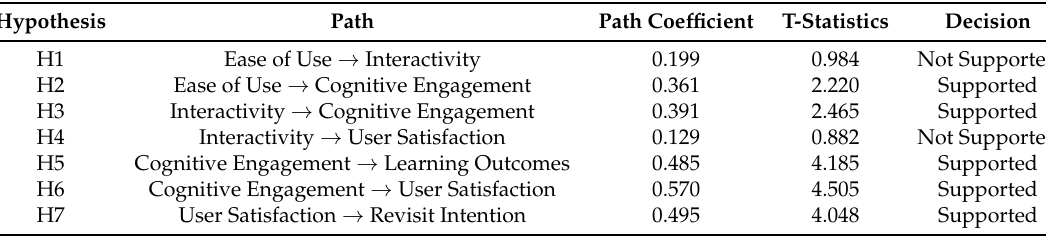
Table 6. Hypothesis